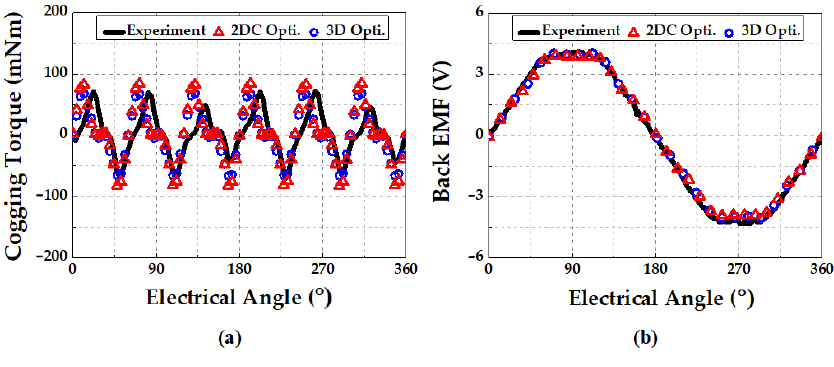
Figure 12. RSM results for the ( a ) cogging torque and ( b ) back EMF.